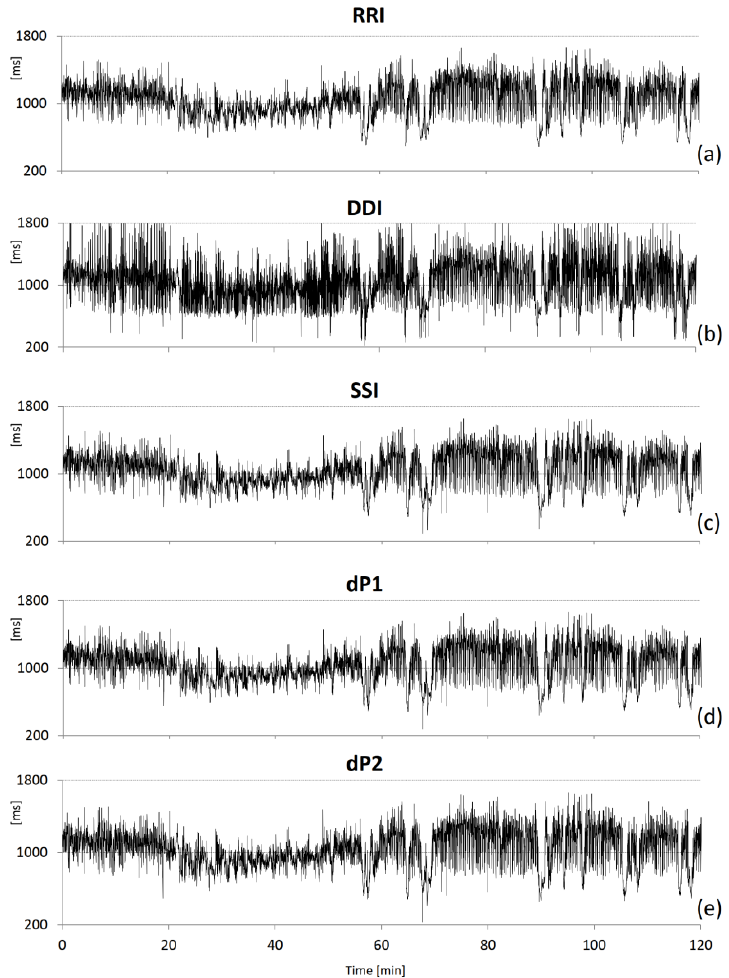
Figure 2. Example of IBI series during sleep at high altitude. ( a ) RRI from the ECG (reference); ( b ) DDI from the transmitted light (TL); ( c ) SSI from the absorbed light (AL = − TL); ( d ) dP1 from AL 1st derivative and ( e ) dP2 from AL 2nd derivative.